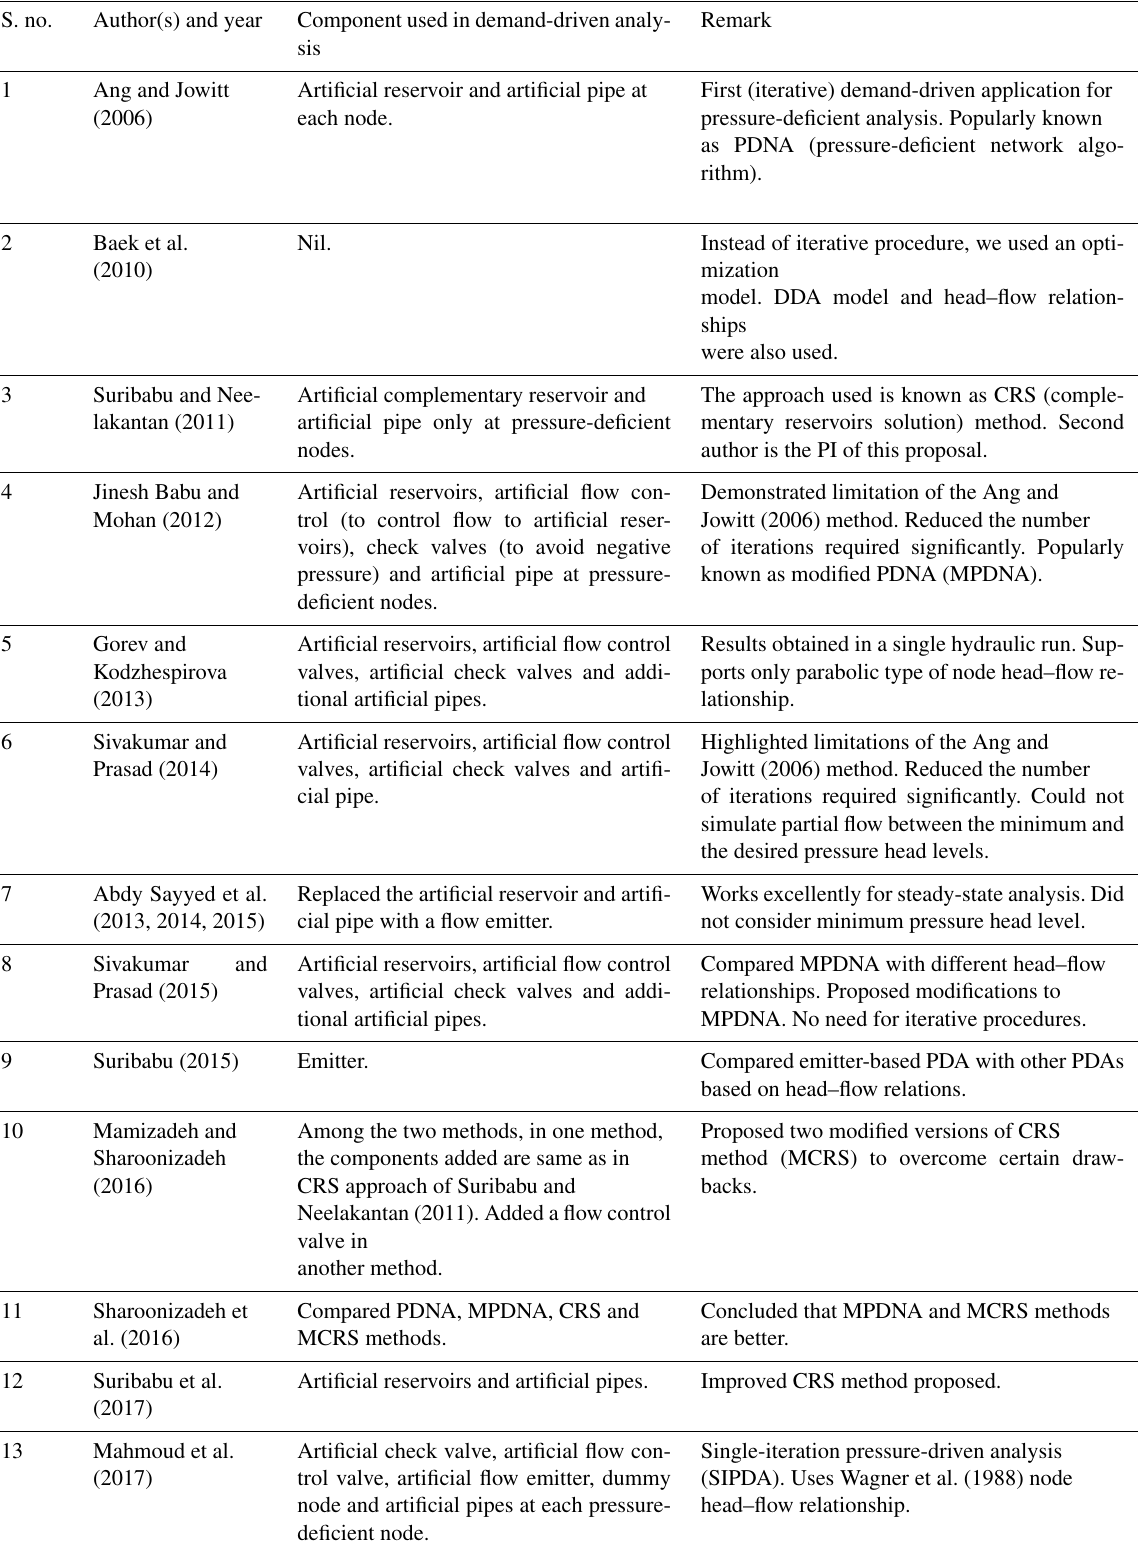
Table 2. Use of artificial components in